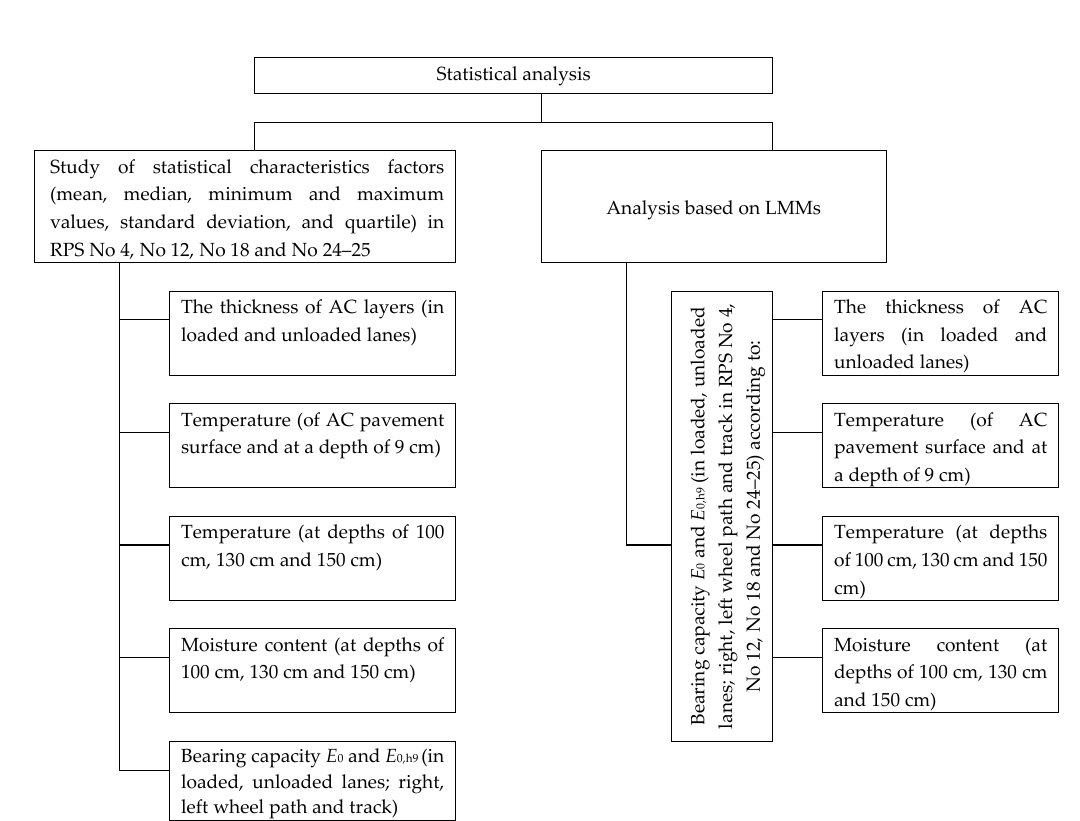
Figure 3. Statistical analysis of the experiment.